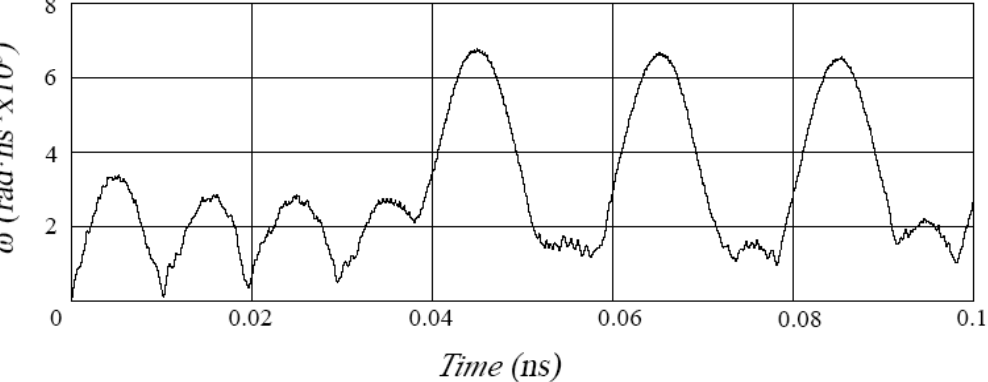
Figure 8. Angular velocity of buckminsterfullerene.